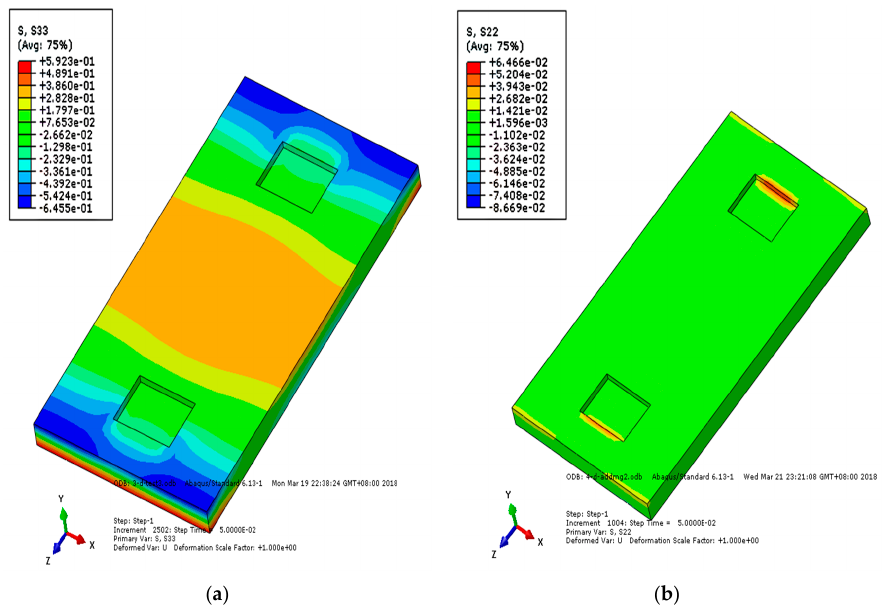
Figure 17. Stress nephogram of substructure under the action of axle falling: ( a ) longitudinal stress of base; ( b ) vertical stress of base.